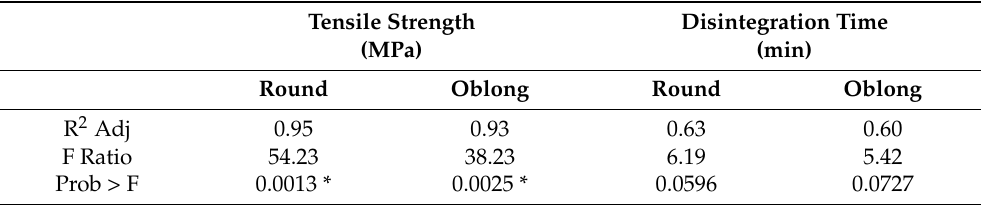
Table 6. Statistical analysis of the mixture design formulation